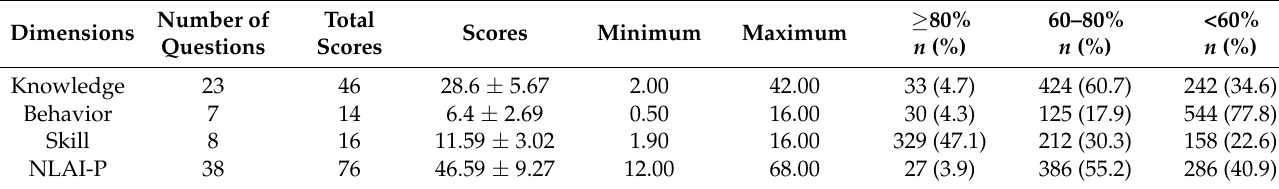
Table 8. The NLAI-P scores of pregnant women in